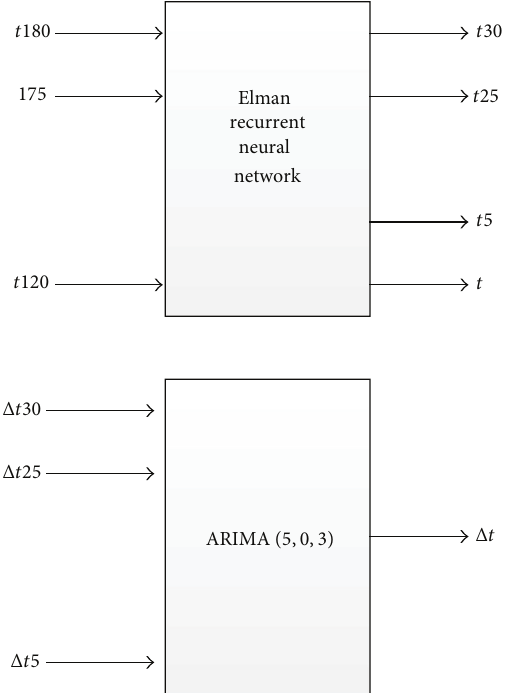
Figure 3: Scheme of the hybrid model.